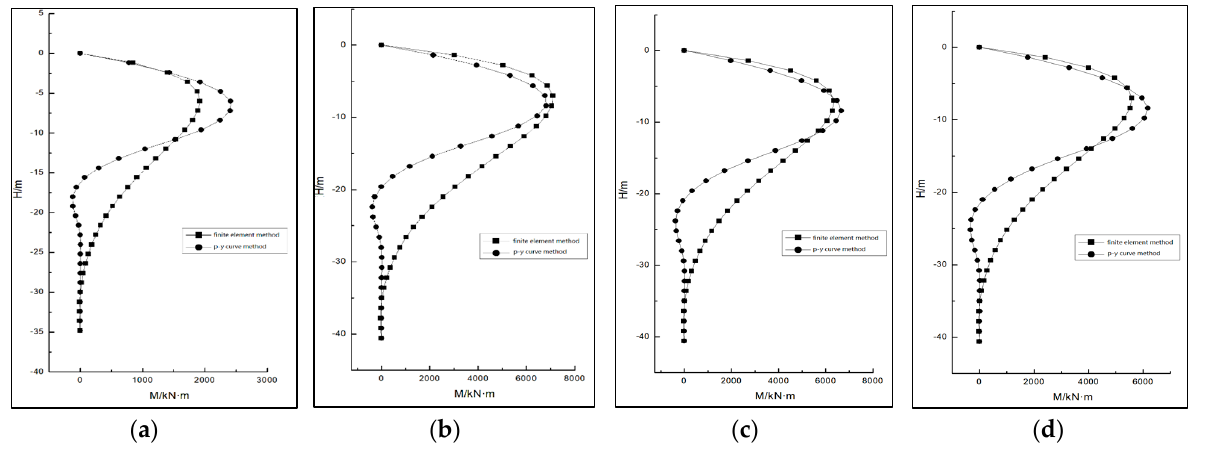
Figure 20. Pile bending moment behavior: ( a ) inclined pile; ( b ) front pile; ( c ) middle pile; ( d ) back pile.